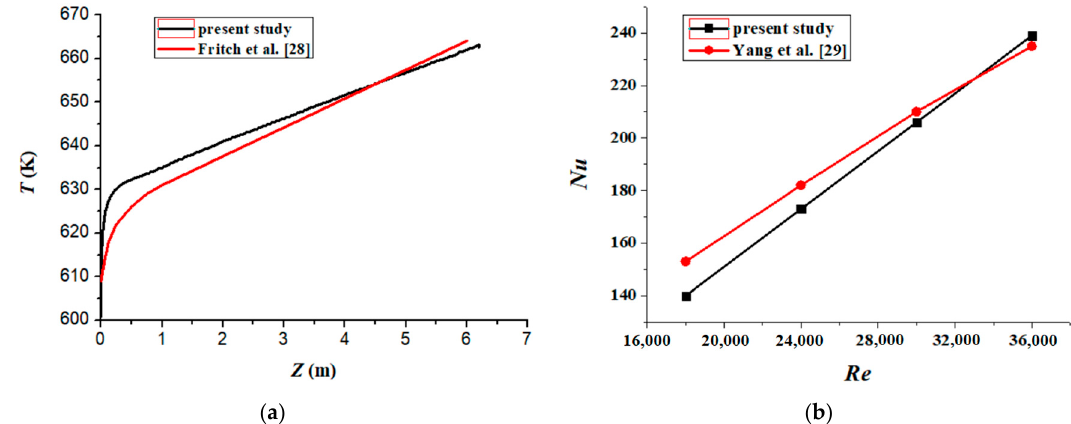
Figure 7. Validation of the computational method: ( a ) temperature distribution on the front side of the tube obtained in this simulation and in the simulation of Fritsch et al. [28]; ( b ) average Nu on the inner wall of tube in this simulation and in the experiment of Yang et al. [29].